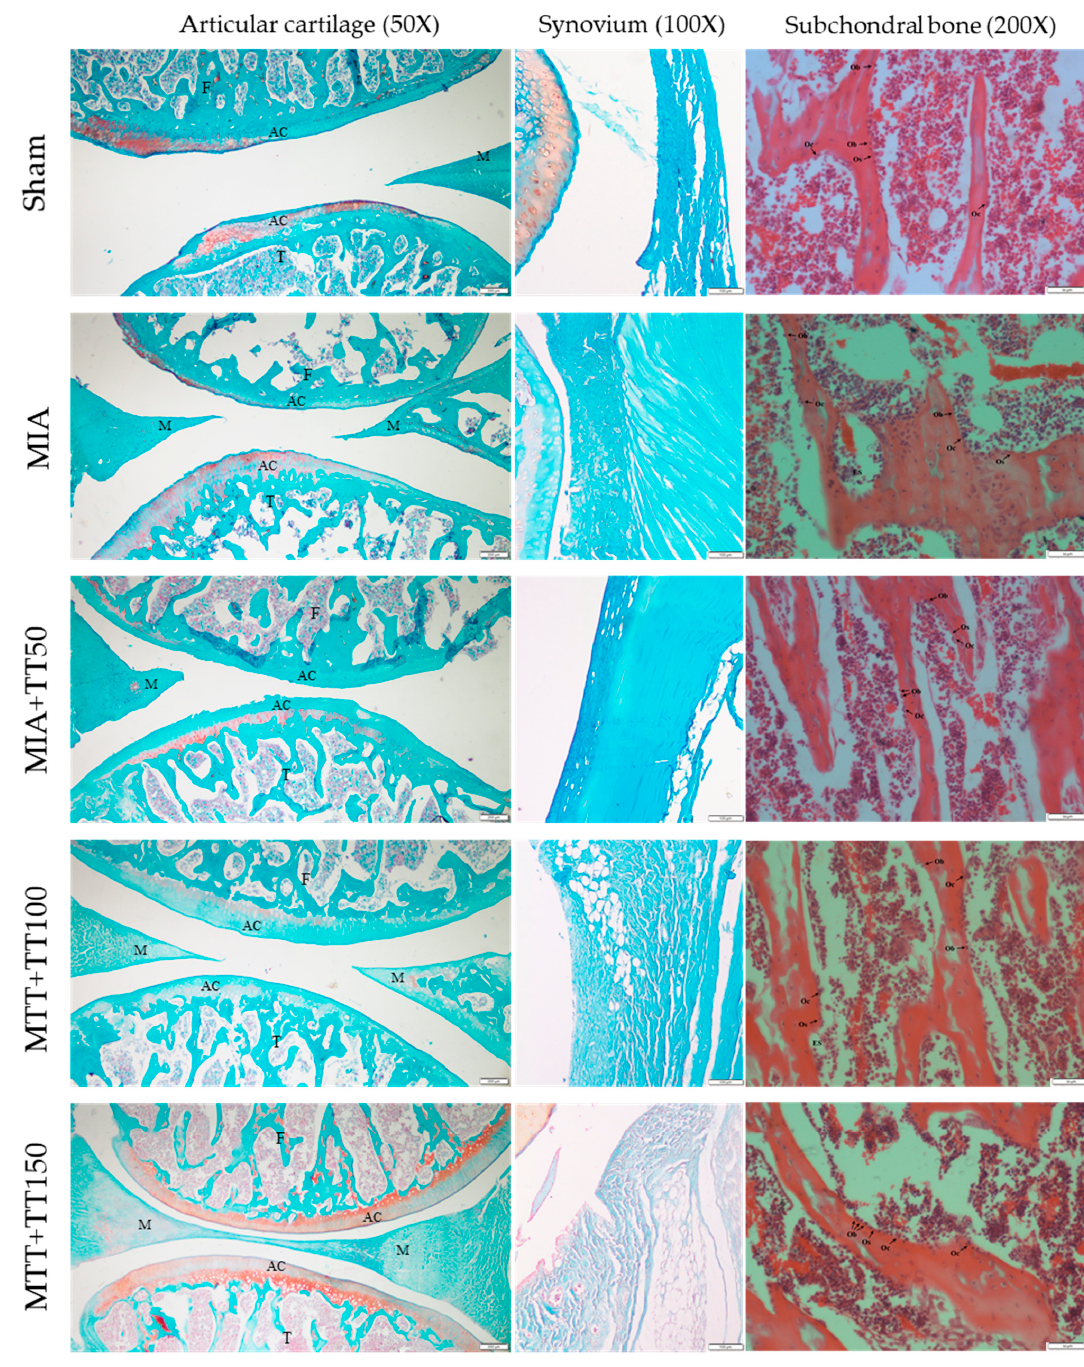
Figure 2. Micrographs of the knee joints of the rats receiving different treatments. Abbreviation: AC, articular cartilage; F, femur; M, meniscus; T, tibia; Ob, osteoblast; Oc, osteoclast; Os, osteoid; ES, eroded surface.